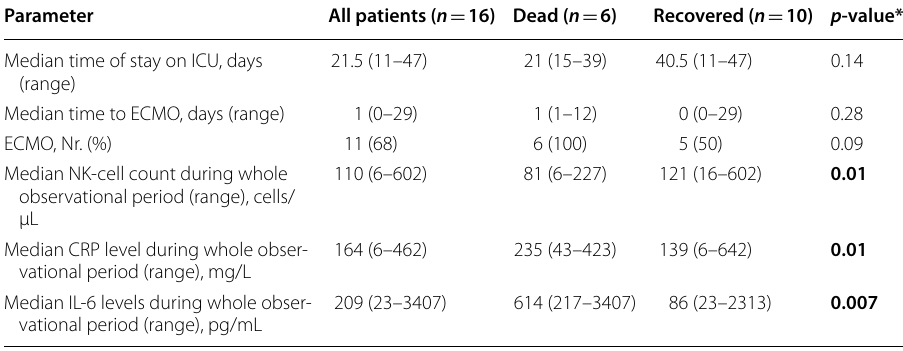
p ‑values in bold reflect statistical significance at a level of p ‑value < 0.05 ECMO extracorporeal membrane oxygenation, NK natural‑killer cells, IQR interquartile range, CRP C‑reactive protein, IL-6 interleukin‑6, ICU intensive care unit *Based on independent median test and Pearson Chi‑square test/Fisher’s test, corrected for multiple